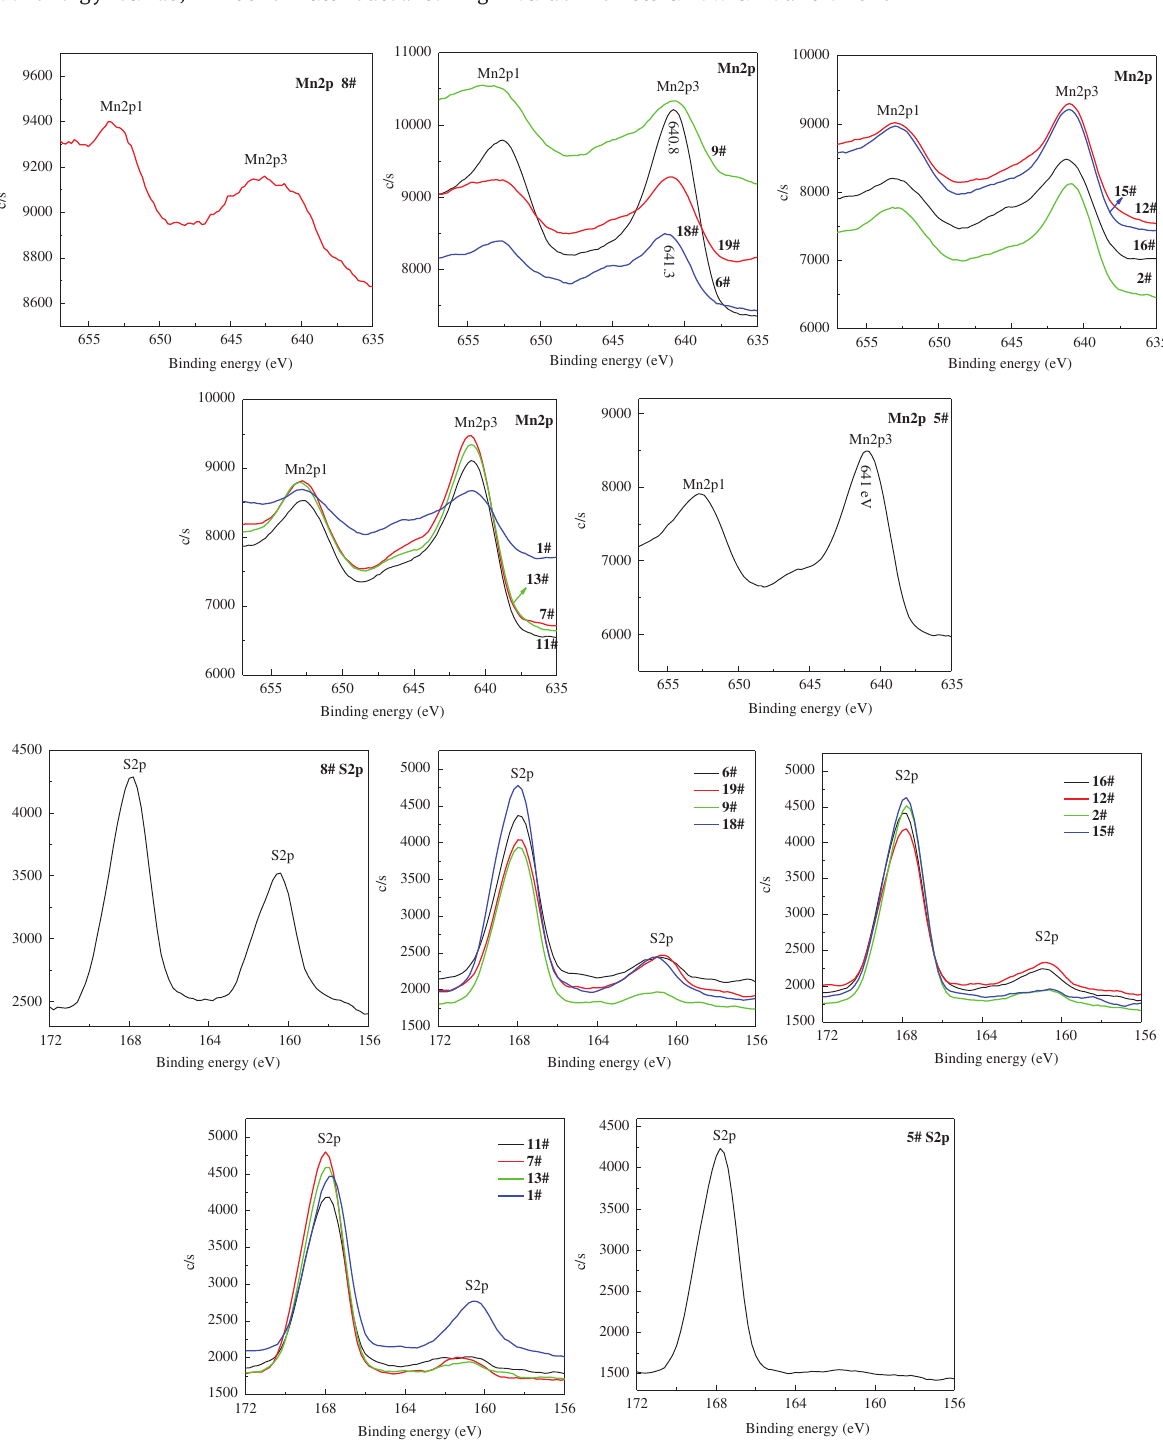
Figure 7. S2p diffraction peaks can be divided into two energy bands, ~ 168 eV attributed to high value